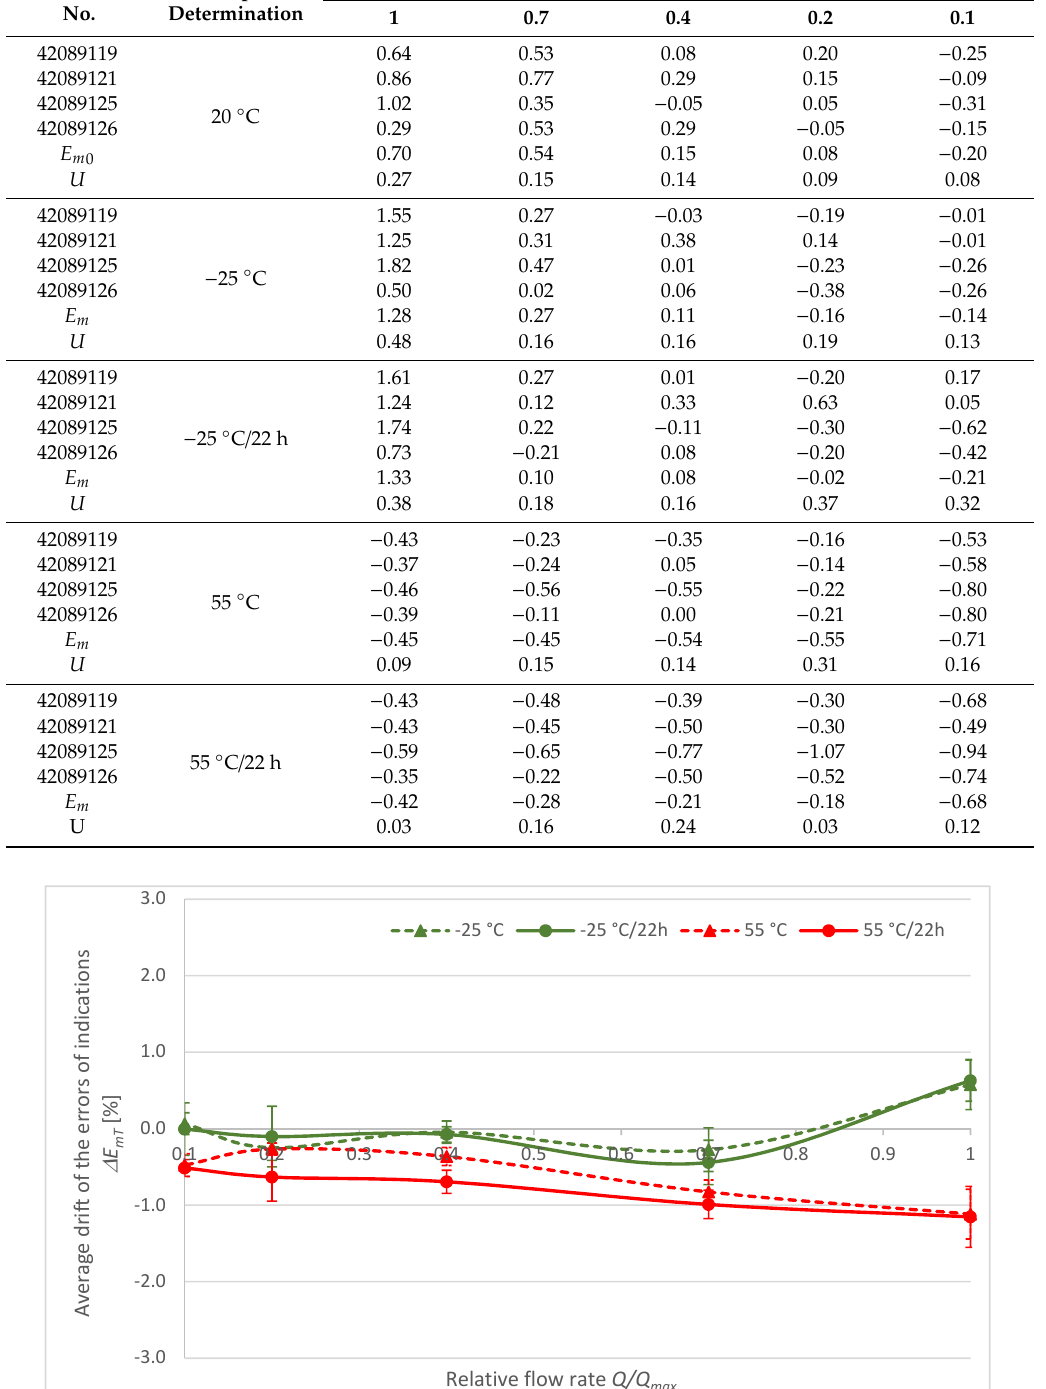
Figure 10. Average drift of errors of indications ( Δ E mT ) with the confidence interval ( u ) of thermal gas meters at ambient and gas temperatures of − 25 °C and 55 °C, respectively, as a function of the relative flow rate ( Q/Q max ).